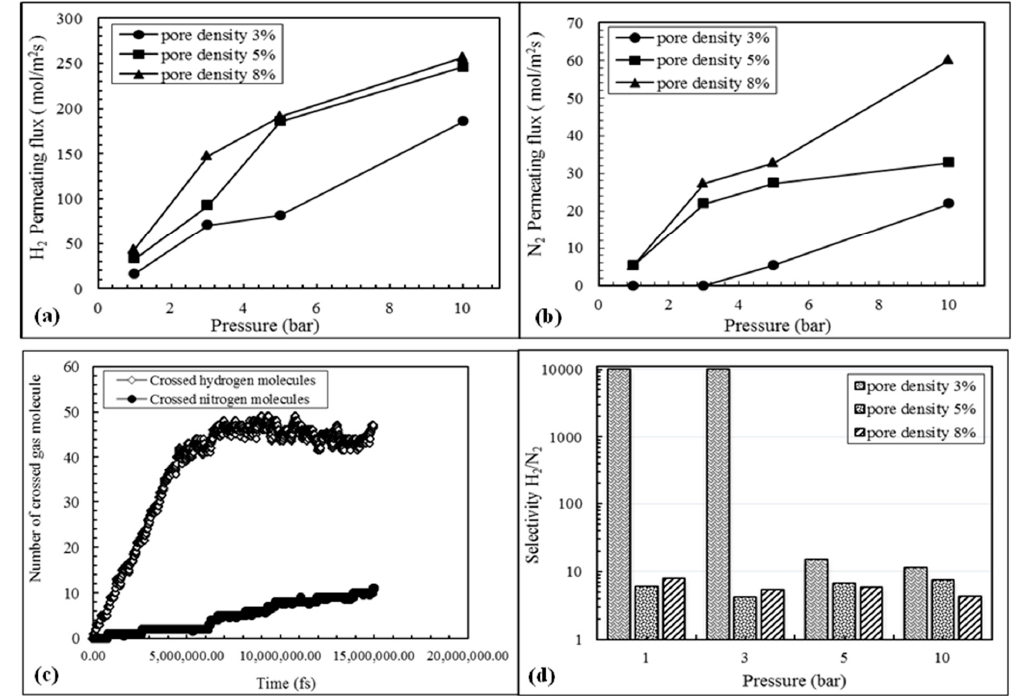
Figure 4. ( a ) Permeate flux of the hydrogen (mol/m 2 s), ( b ) permeate flux of nitrogen (mol/m 2 s) for various pore densities, ( c ) number of crossed gas molecule for pore density of 5%, ( d ) selectivity of H 2 /N 2 .